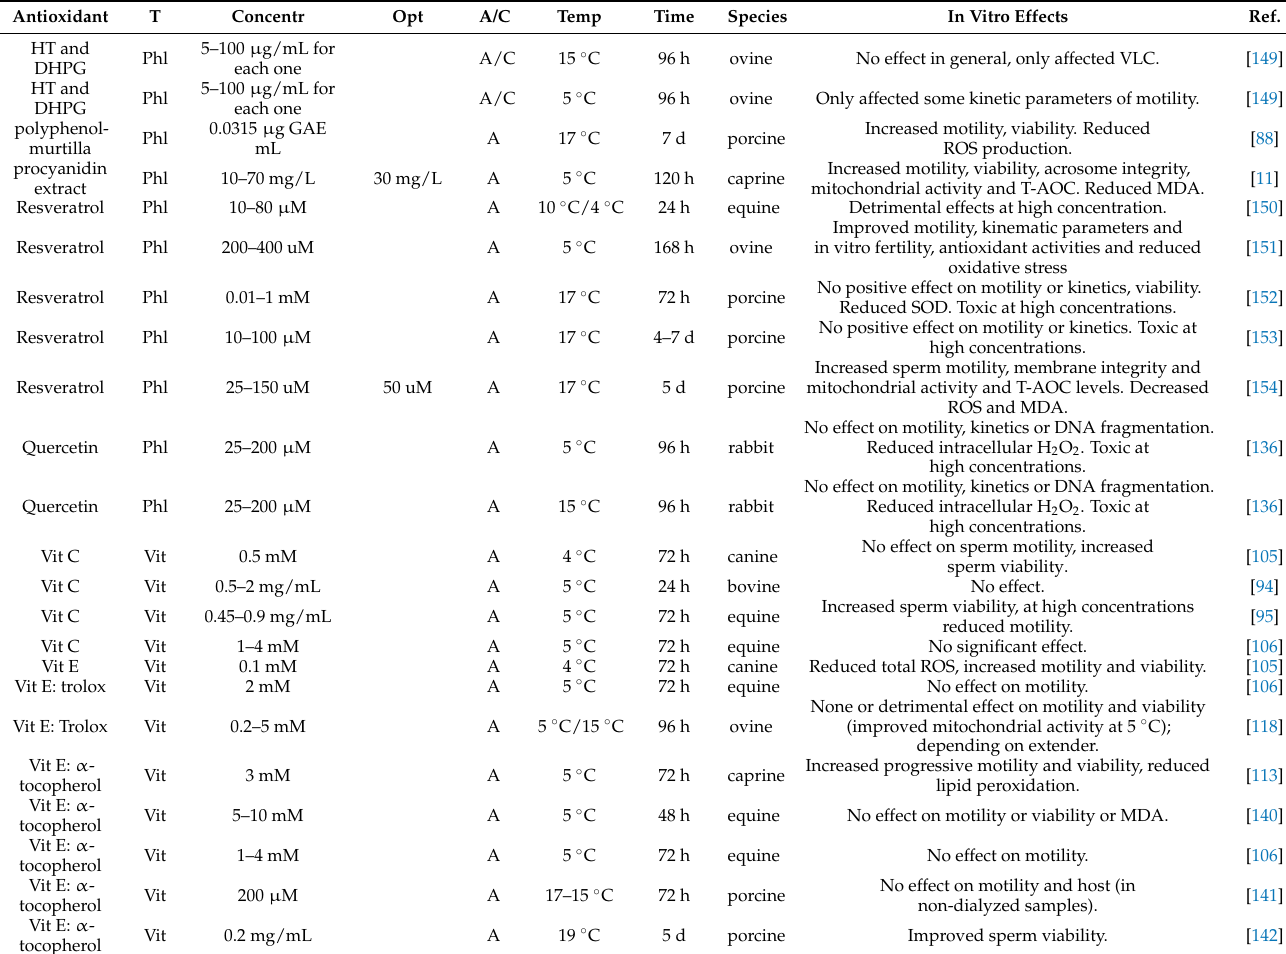
Only affected some kinetic parameters of motility.